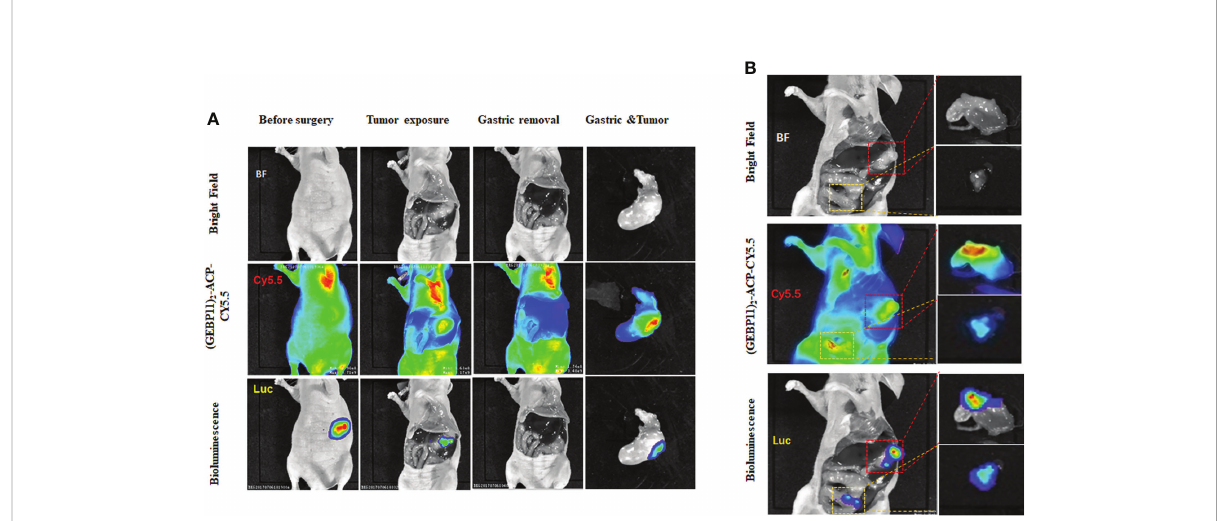
FIGURE 5 Intraoperative detection and resection of gastric cancer by (GEBP11) 2 -Acp-Cy5.5 probe. (A) Representative bioluminescence imaging (BLI) and fl uorescence images of mice before and after surgery in orthotopic xenografts models under fl uorescence guidance; (B) Intraoperative detection of peritoneal metastasis detected by white light imaging, BLI and molecular fl uorescence-guided surgery (The red box represents gastric cancer in situ, the white box represents peritoneal metastasis